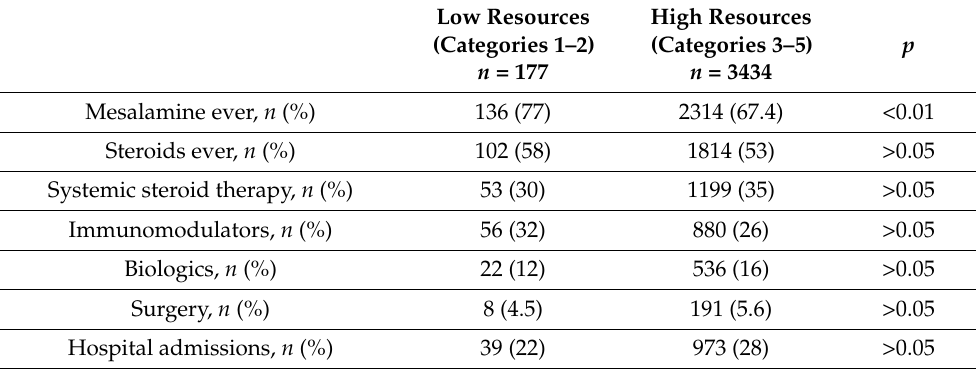
Table 5. Prevalence of exposure to different drug treatments, surgery and hospitalizations based on hospital